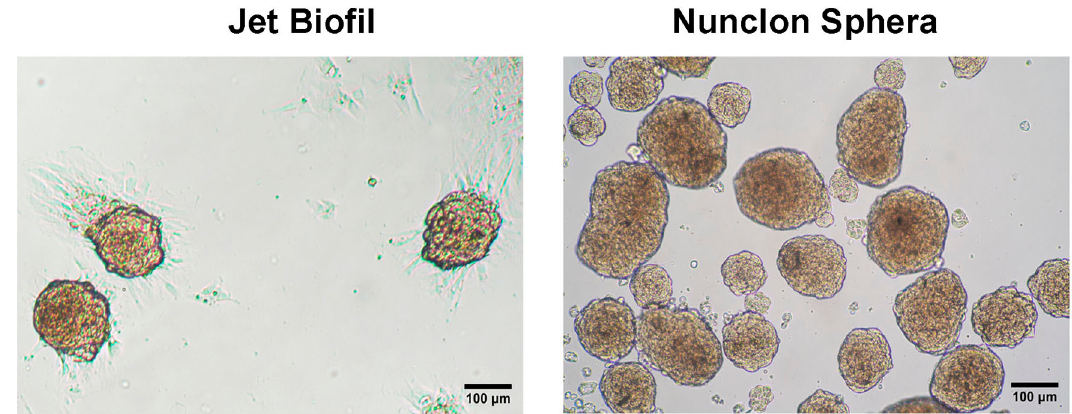
Figure 2- The light microscopic images show the morphology of neurospheres generated from DPSCs. Neurospheres 4-days cultured on the Jet Biofil non-treated plate attached to the surface of the plate (Left). Neurospheres cultured on the Nunclon Sphera plate freely floated and showed smooth rims